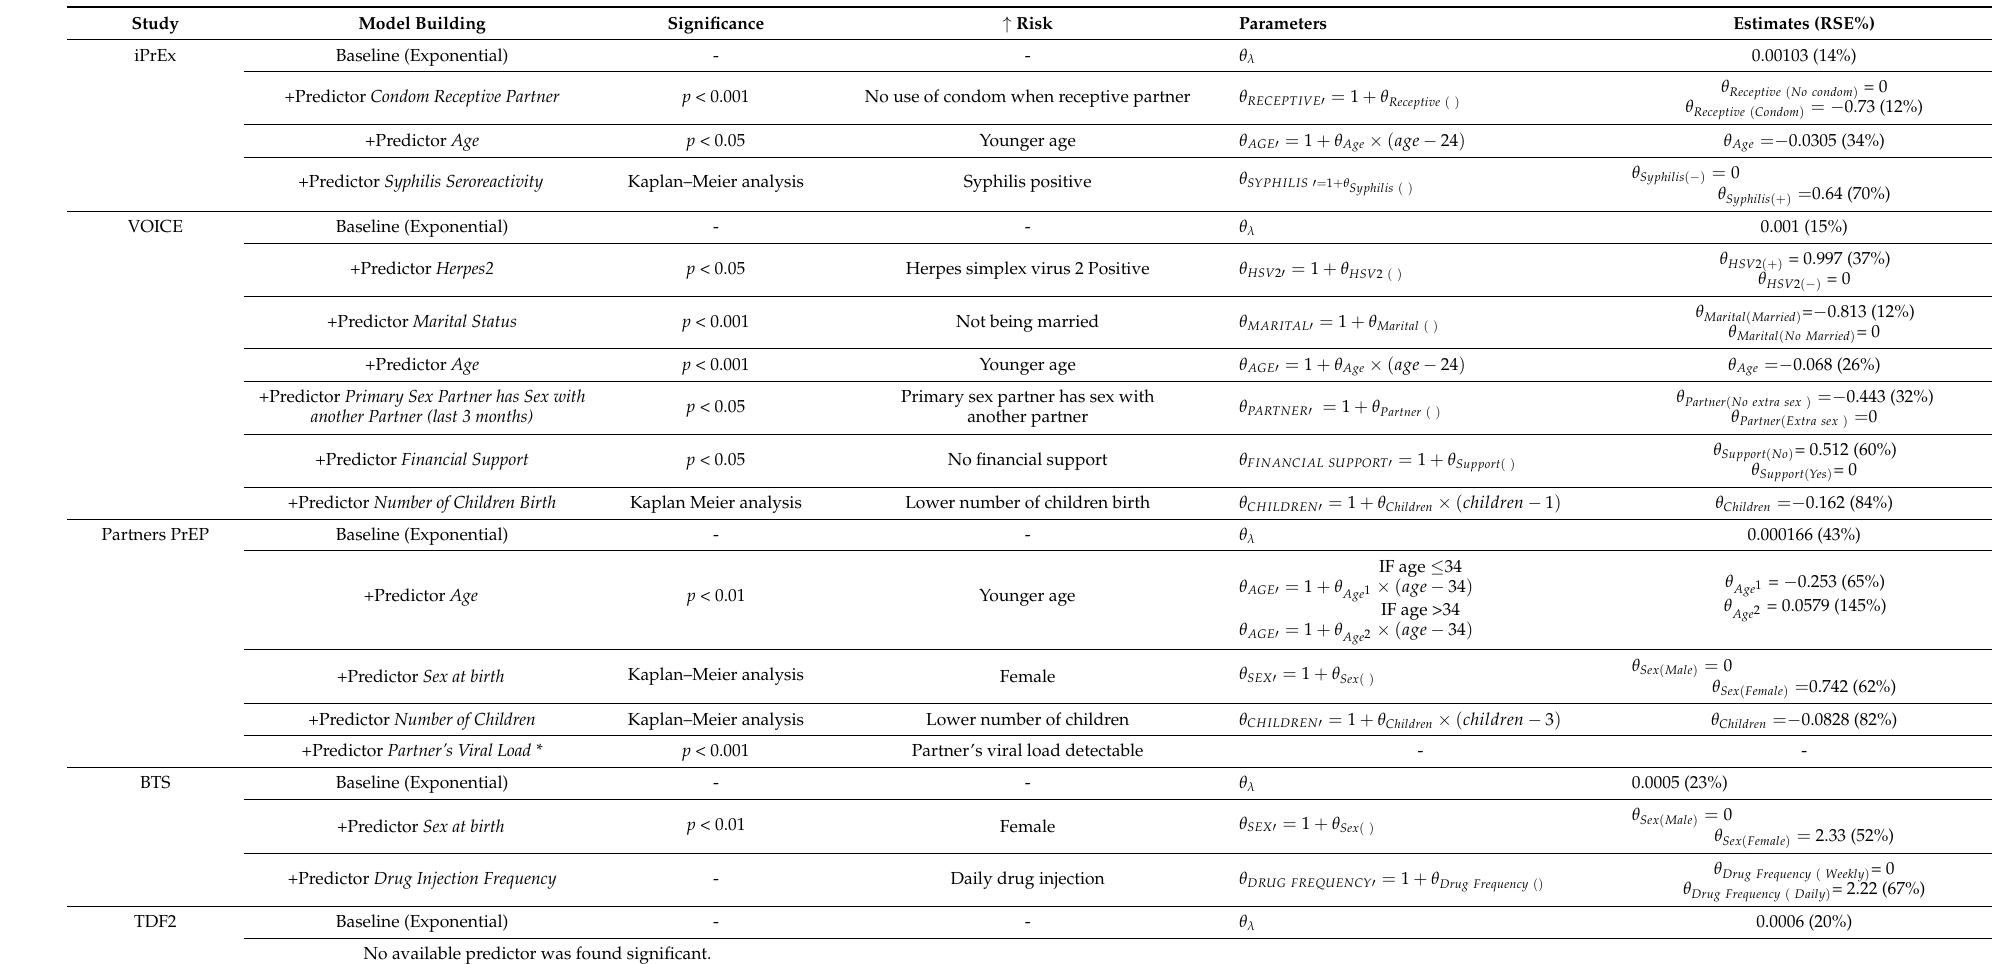
Table 2. Final multivariate model by